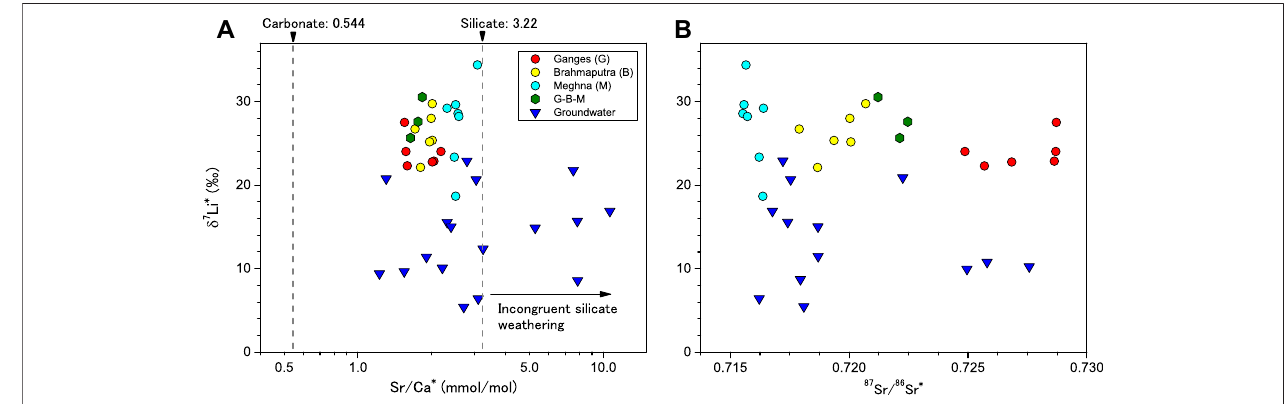
FIGURE 4 | Correlations between (A) δ 7 Li and Sr/Ca and (B) δ 7 Li and 87 Sr/ 86 Sr of the Ganges, Brahmaputra, and Meghna rivers and groundwater in the Bengal Plain. Dashed lines represent the mean Sr/Ca values of silicate (3.22 mmol/mol) and carbonate (0.544 mmol/mol) weathering inputs in the Ganges River (Bickle et al., 2018). Incongruent dissolution and sorting effects of silicate materials results in the high Sr/Ca ratios of the silicate fractions of bedload (Yoshimura et al.,